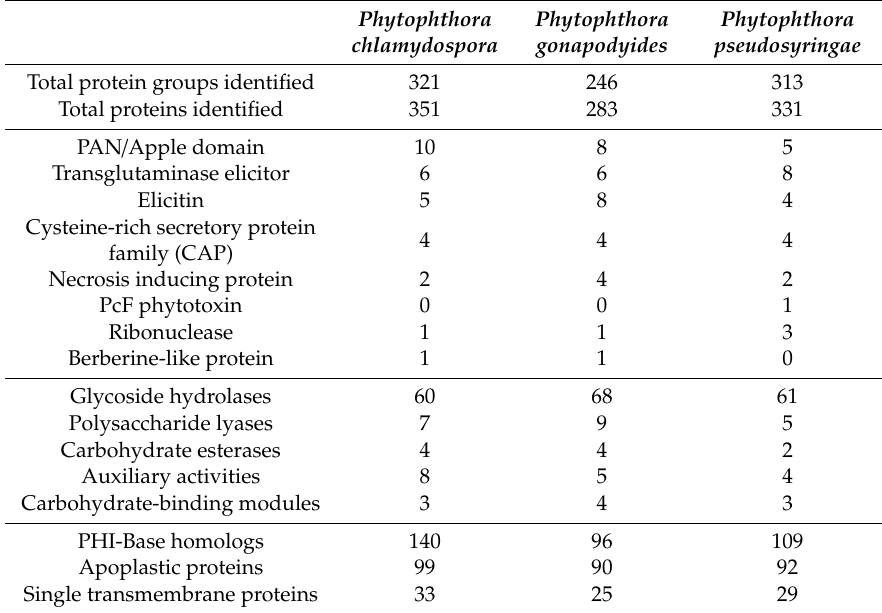
Table 6. Extracellular Phytophthora proteins identified by LC-MS / MS that are putatively involved in osmotrophy or